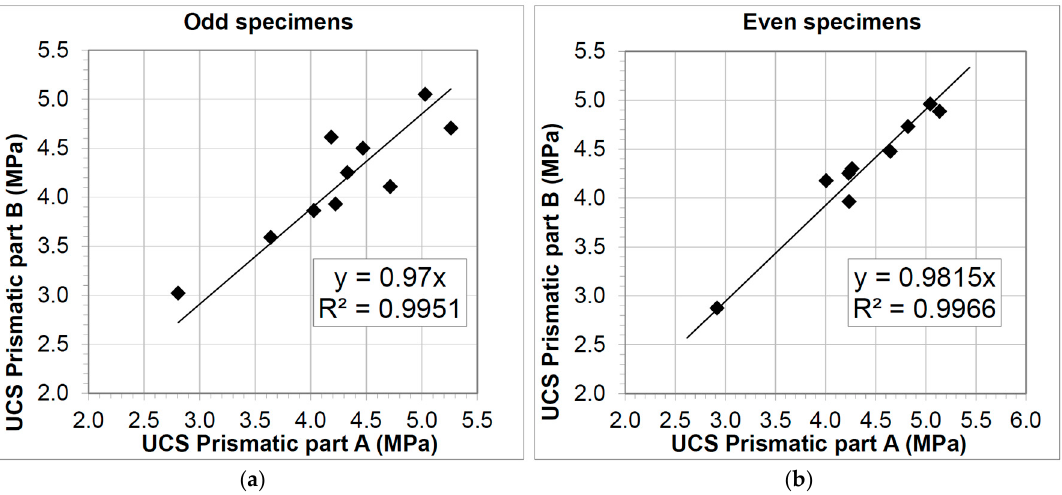
Figure 8. Relationships between UCS of prismatic parts from the same specimen: ( a ) odd specimens; ( b ) even specimens. Table 10. Statistical analysis of the relationship between UCS of the prismatic parts from the same